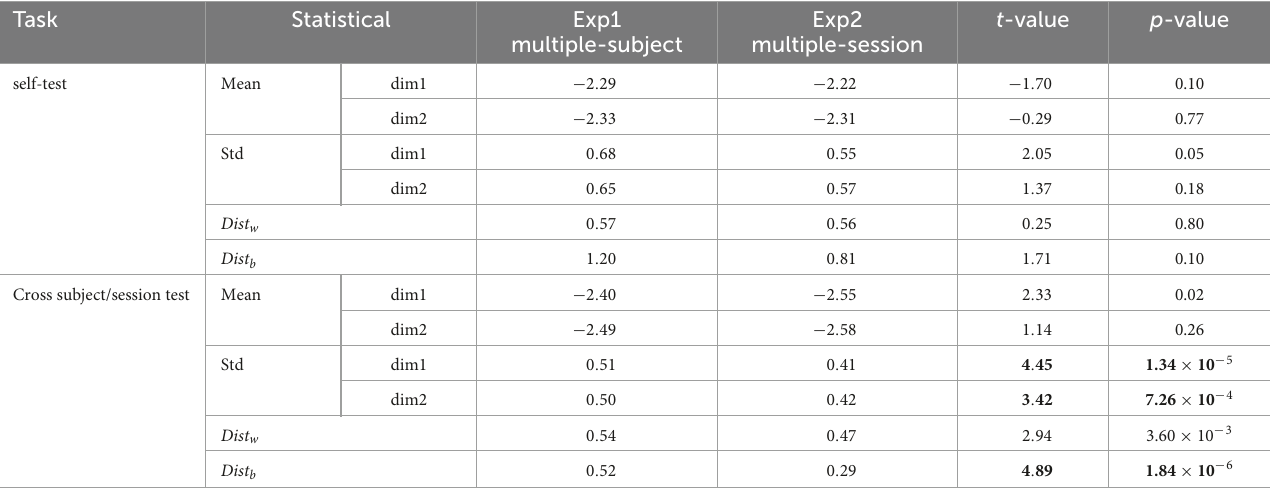
TABLE 1 t -test result on the statistical of Mean, Std, Dist w , Dist b for CSP features. Task